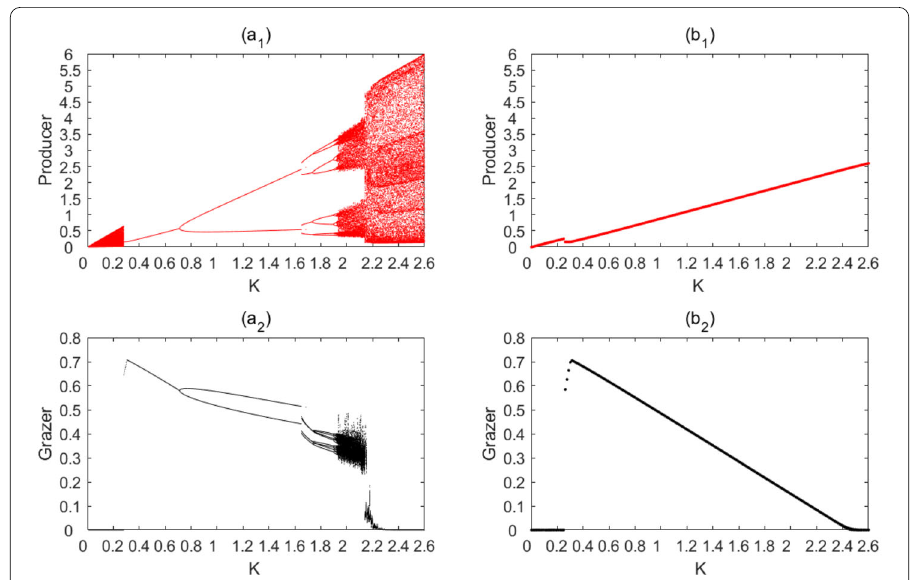
Figure 4 The bifurcation curves versus K for the discrete-time model ( a i , i = 1,2) and the continuous-time model ( b i , i = 1,2). All parameters are as in Table 1 except that b = 2.9 and K varying from 0 to 2.6